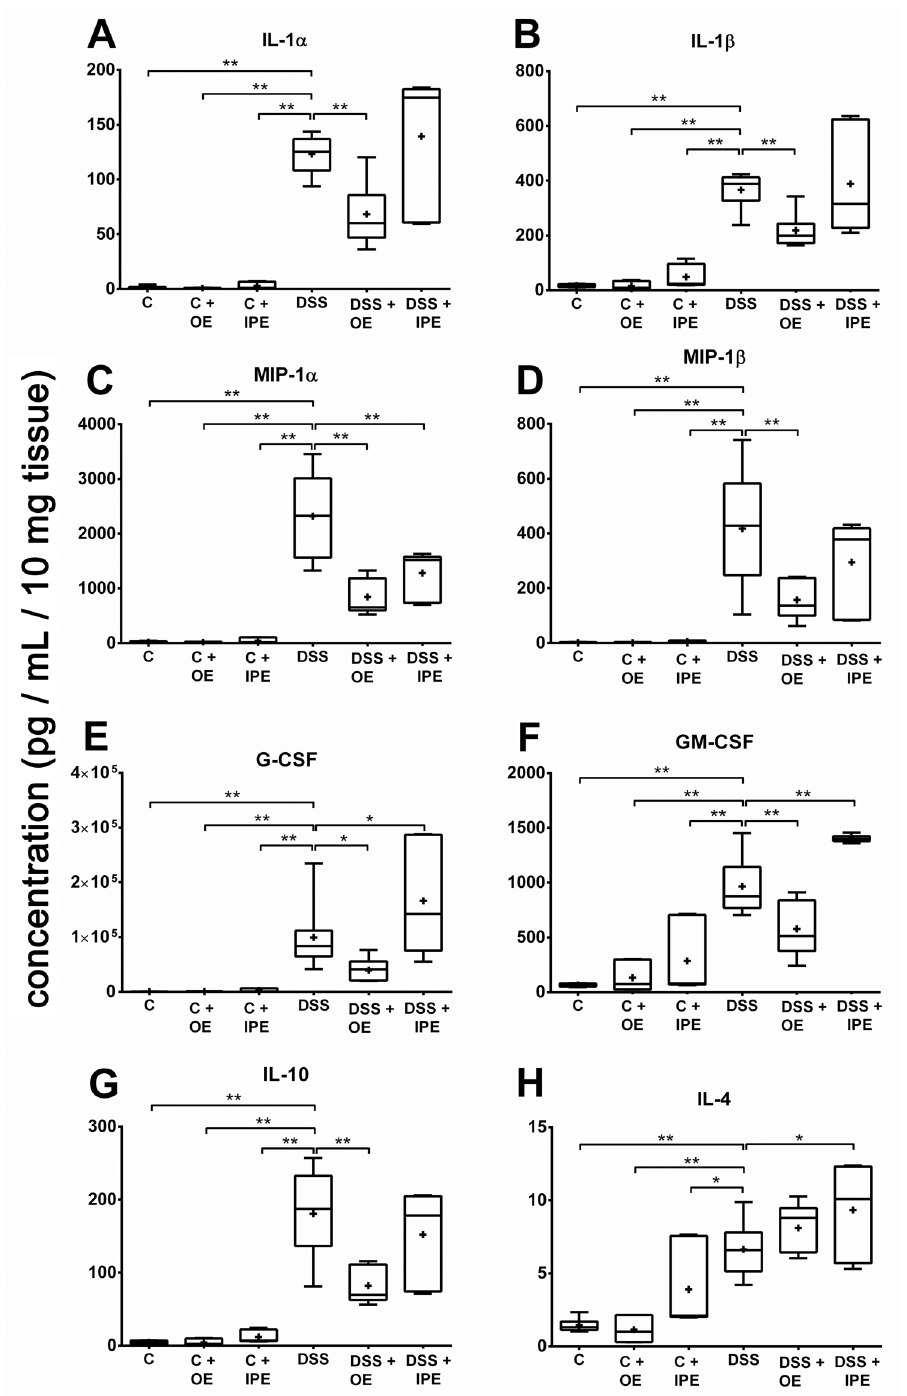
Fig 5. Effect of enoxaparin on colonic cytokine levels. Distal colon tissues of mice were cultured for 24 hours. Supernatants were collected and cytokine levels were measured using Bio-Plex assay. Cytokine levels in the supernatant were normalized to tissue weight to obtain pg / mL of cytokines/ 10 mg of tissue. Results are expressed as minimum, 25th percentile, median, mean, 75th percentile and maximum of cytokine levels of 3 – 5 mice. * p < 0.05 and ** p < 0.01. Interleukin, IL; macrophage inflammatory protein, MIP; granulocyte colony-stimulating factor, G-CSF; granulocyte – macrophage colony-stimulating factor, GM-CSF; Control, C; control with oral enoxaparin, C+OE; control with intraperitoneal injection of enoxaparin,